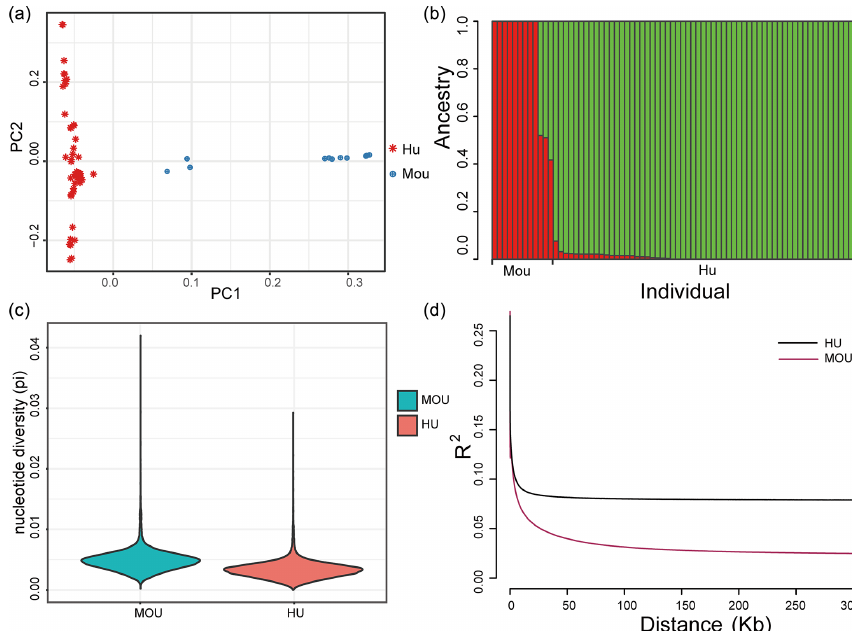
Figure 1. Population structure of the indigenous Hu sheep and Asiatic mouflon sheep populations. (a) Principal component analysis (PCA) plot of sheep populations; the first (PC1) and second (PC2) components were plotted, and the red and blue color represent Hu sheep and mouflon sheep, respectively. (b) Population genetic structure of ancestry compositions in a total of 71 sheep by ADMIXTURE, with the assumed number of ancestries being two. (c) The nucleotide diversity of the sheep population in this study. The blue block indicates the nucleotide diversity coefficient of the wild mouflon sheep population, and the red block indicates the nucleotide diversity coefficient of the domestic Hu sheep population. (d) Genome-wide linkage disequilibrium of sheep. The black line represents the wild sheep population, and the red line represents the domestic Hu sheep population; the LD of the domestic sheep population decayed faster than the wild sheep population.